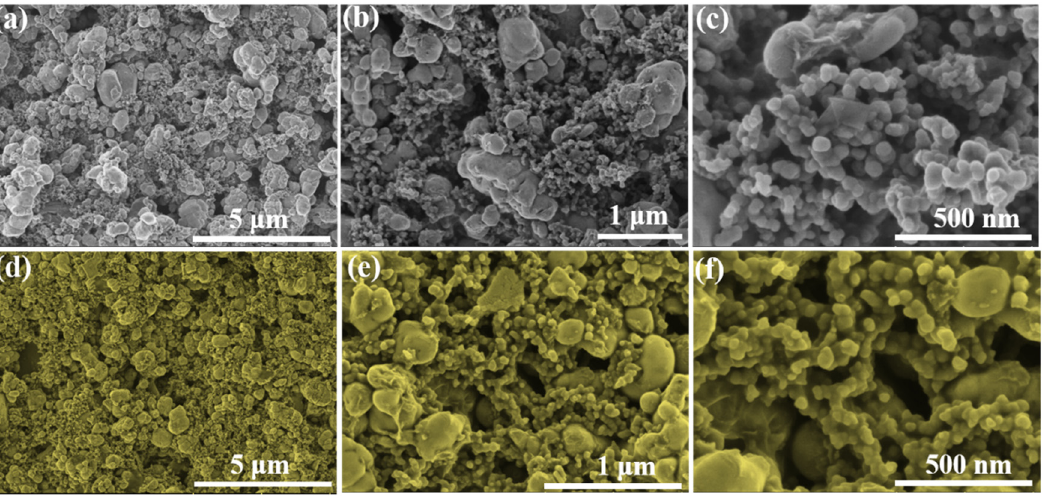
Figure 3: SEM images of fresh ( a – c ) LFP – PVDF and ( d – f ) LFP – PI electrode fi lms.